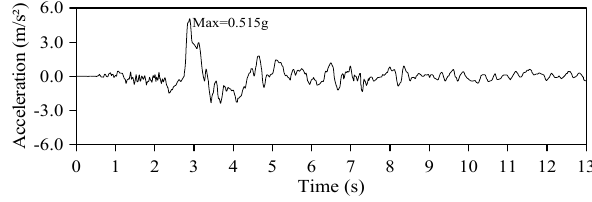
Fig. 7. The time-history of ground motion acceleration of 1992 Erzincan.